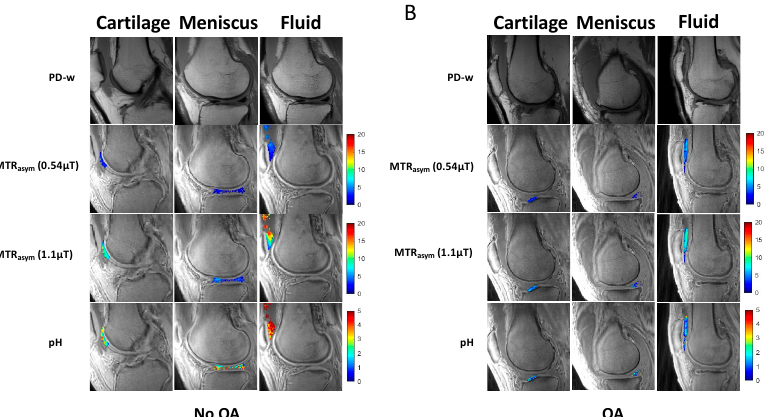
Figure 1. Representative image examples from patients without OA ( A ) and with OA ( B ). Sagittal